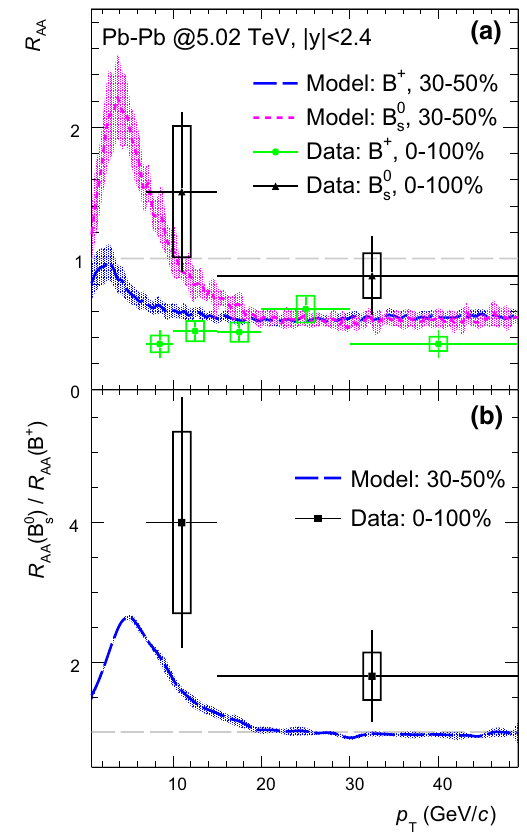
Fig. 6 a Comparison of R AA ( B + ) (long dashed blue curve) and R AA ( B 0 s ) (dashed pink curve) in semi-central (30–50%) Pb–Pb col- √ s NN = 5 . 02 TeV. The experimental data for R AA ( B + ) lisions at (greencirclepoint[59])and R AA ( B 0 s ) (blacktrianglepoint[60])arecol- lected from the minimum-bias events (0–100%). b R AA ratio between R AA ( B 0 s ) and R AA ( B +